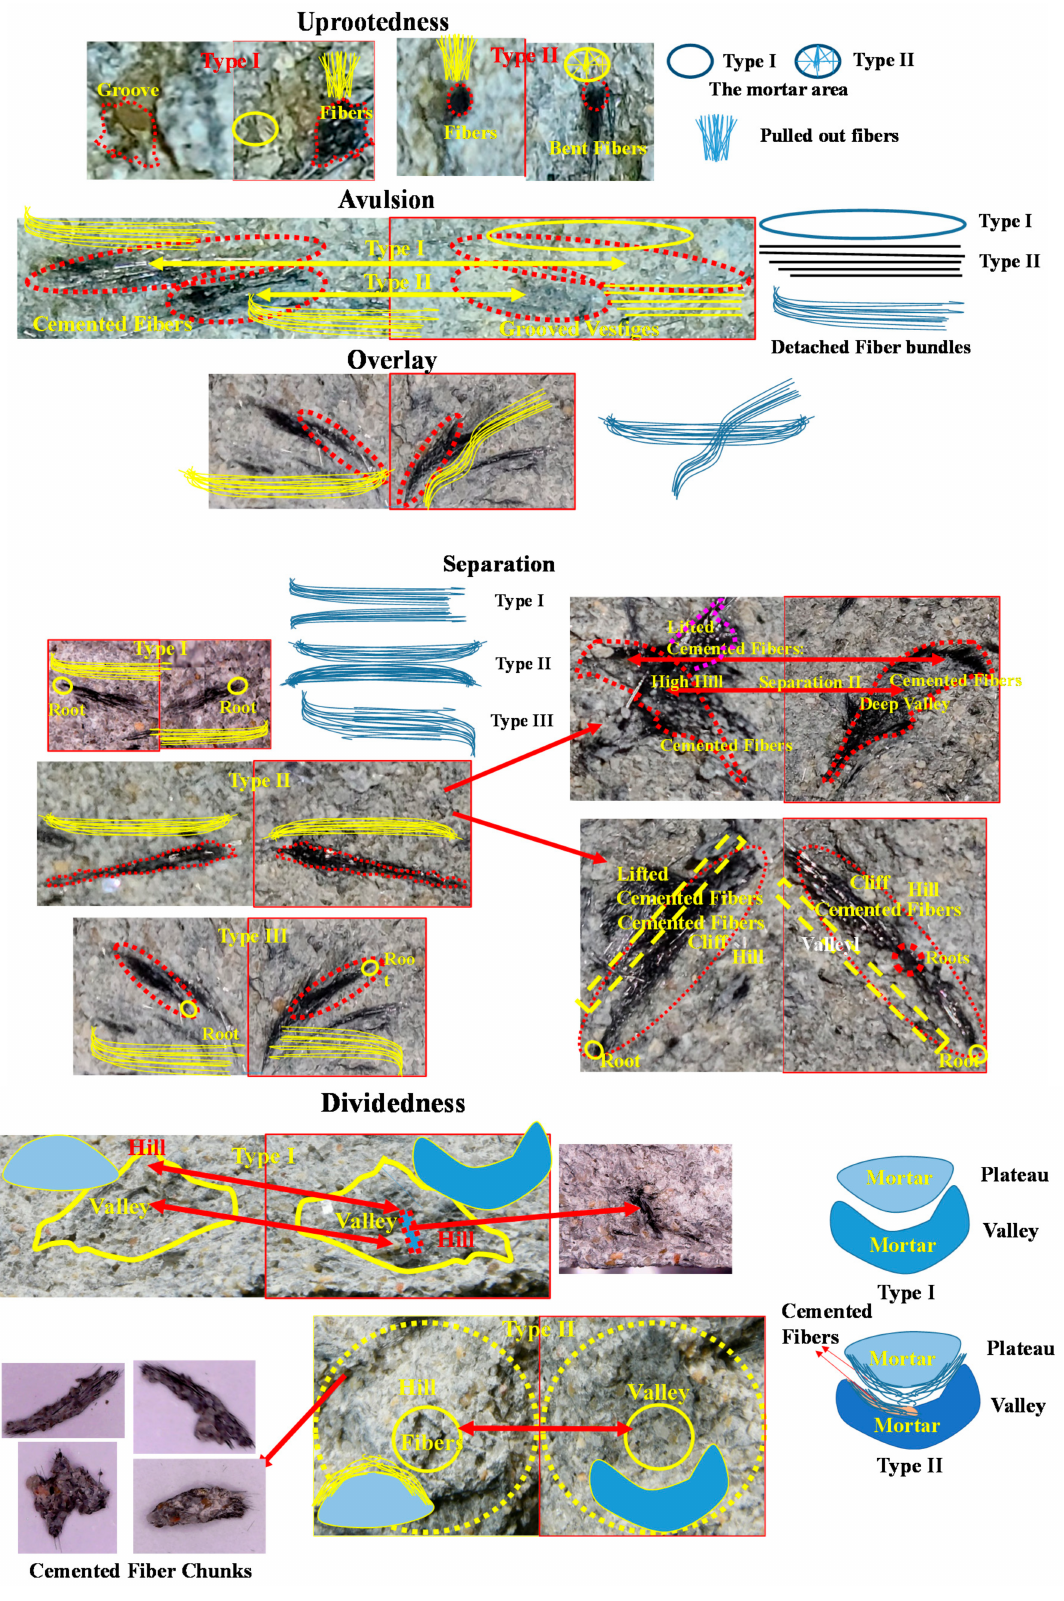
Figure 5. Real examples of five traces corresponding to Figure 4. The illustrated fiber traces in Figure 4 are compared with the real examples to show their